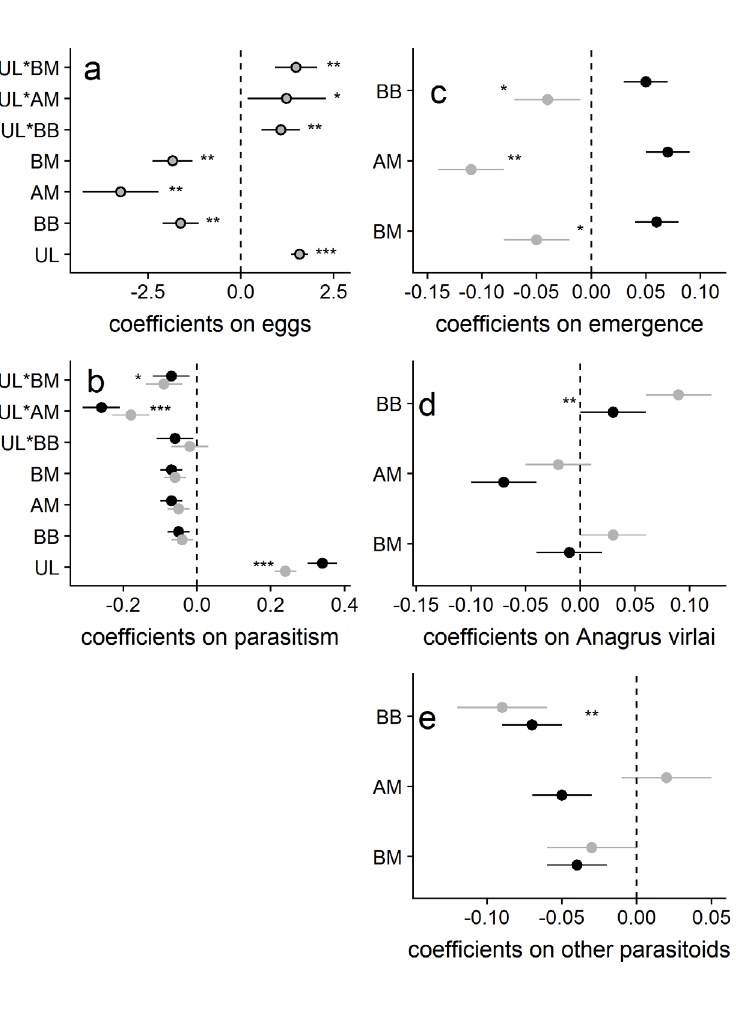
Figure 2. a Effect estimates for a zero- inflated negative binomial model of the number of Dalbulus maidis eggs. b Effect estimates for a Gaussian model on parasitism (black points) accounting for the number of exposed Dalbulus maidis eggs (gray points). c Effect estimates for a Gaussian model on the proportion of emergence of parasitoids (black points) taking into account the number of parasitoids of Dalbulus maidis (as offset) (gray points) in unfolded leaves of V4 plants. d Effect estimates for a Gaussian model on the proportion of emergence of Anagrus virlai (black points) accounting for the proportion of emergence of other wasp species (gray points) in unfolded leaves of V4 plants. e Effect estimates for a Gaussian model on the proportion of emergence of other wasp species (black points) accounting for the proportion of emergence of Anagrus virlai (gray points) in unfolded leaves of V4 plants. BM: Basal midrib; AM: Apical midrib; BB: Basal blade; UL: unfolded leaves. Points depict the coefficient value; the whisker depicts the standard error. Significant differences are indicated by asterisks (* p < 0.05; ** p < 0.01; *** p < 0.001). Detailed statistics are shown in Supplementary